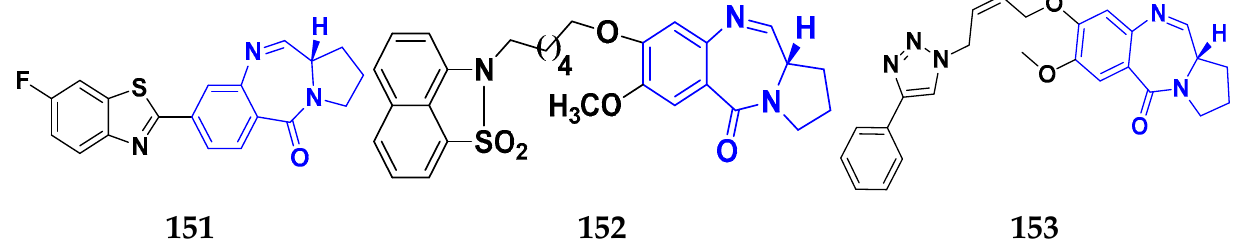
Figure 16. Pyrrolo-benzodiazepines derivatives ( 151 – 153 ) as anticancer agents.